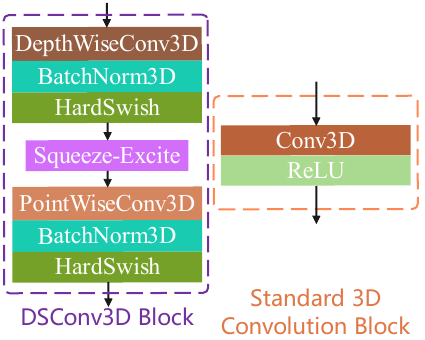
Figure 5. A detailed view of FeatureNetLite; k = 3 denotes convolution kernel size is set to 3.